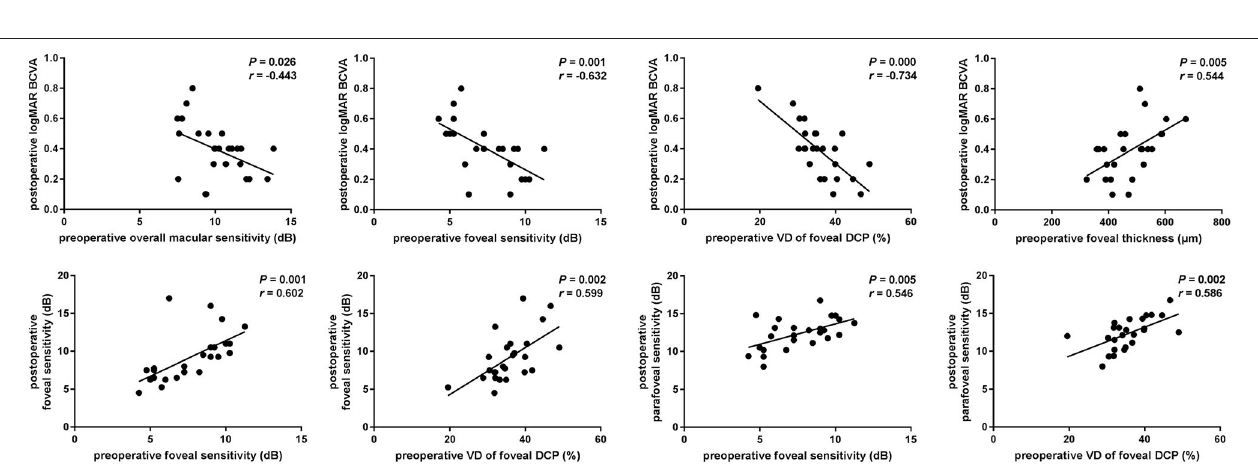
FIGURE 2 | Associations of visual function and OCTA parameters in iERM eyes at baseline. Scatterplots show the statistically significant correlation between preoperative foveal sensitivity and vessel density (VD) of foveal or parafoveal SCP ( r = − 0.596, P = 0.002; r = − 0.438, P = 0.029). Preoperative BCVA was significantly correlated with foveal or parafoveal sensitivity, CFT ( r = − 0.747, P < 0.001; r = − 0.771, P < 0.001; r = 0.457, P = 0.022). FAZ area was significantly correlated with CFT ( r = − 0.444, P = 0.026).